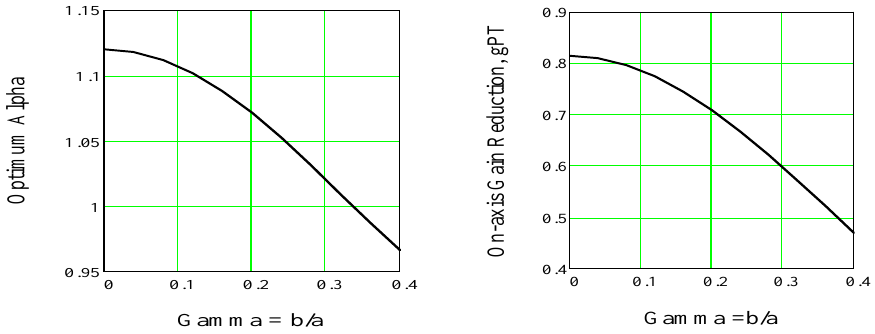
Figure 4. Maximizing the far field gain of the transmitting antenna. The left hand graph gives the ratio of the primary mirror radius to the laser Gaussian beam radius, i.e., α T = a T / ω , which yields maximum on-axis far field gain as a function of the secondary mirror obscuration ratio γ T = b T / a T . The second graph shows the resulting reduction in the peak far field transmitter gain relative to 4 π A T / λ 2 where A T is the area of the primary mirror. The relatively minor effects of secondary mirror support struts on the far field pattern can be minimized by mounting the secondary mirror on an AR-coated window the same diameter as the primary or alternatively using thin supporting blades that are attached to and run parallel to the telescope